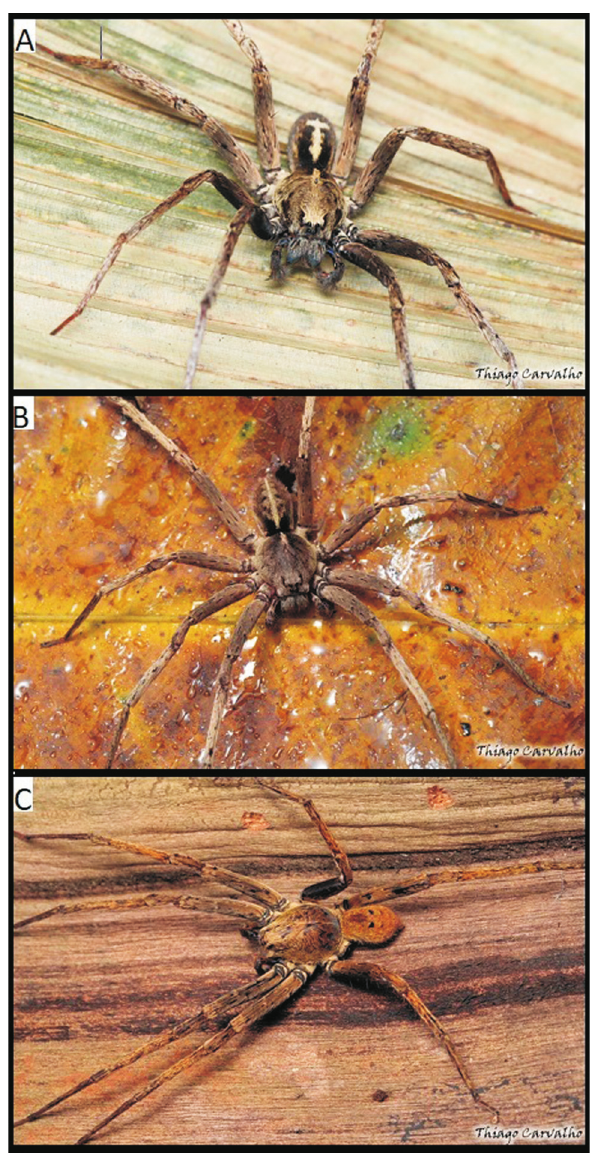
Figure 1 - Spiders species analyzed in the present study: (A) Ctenus am - phora and its specific orange spot in the form of an inverted amphore; (B) Ctenus crulsi showing four medium black spots on the abdomen with black antero-lateral borders; (C) Ctenus villasboasi easily recognized by the coloration and ventral white marks on the coxae and on the apex of the sternum. Photos were taken by Thiago Gomes de